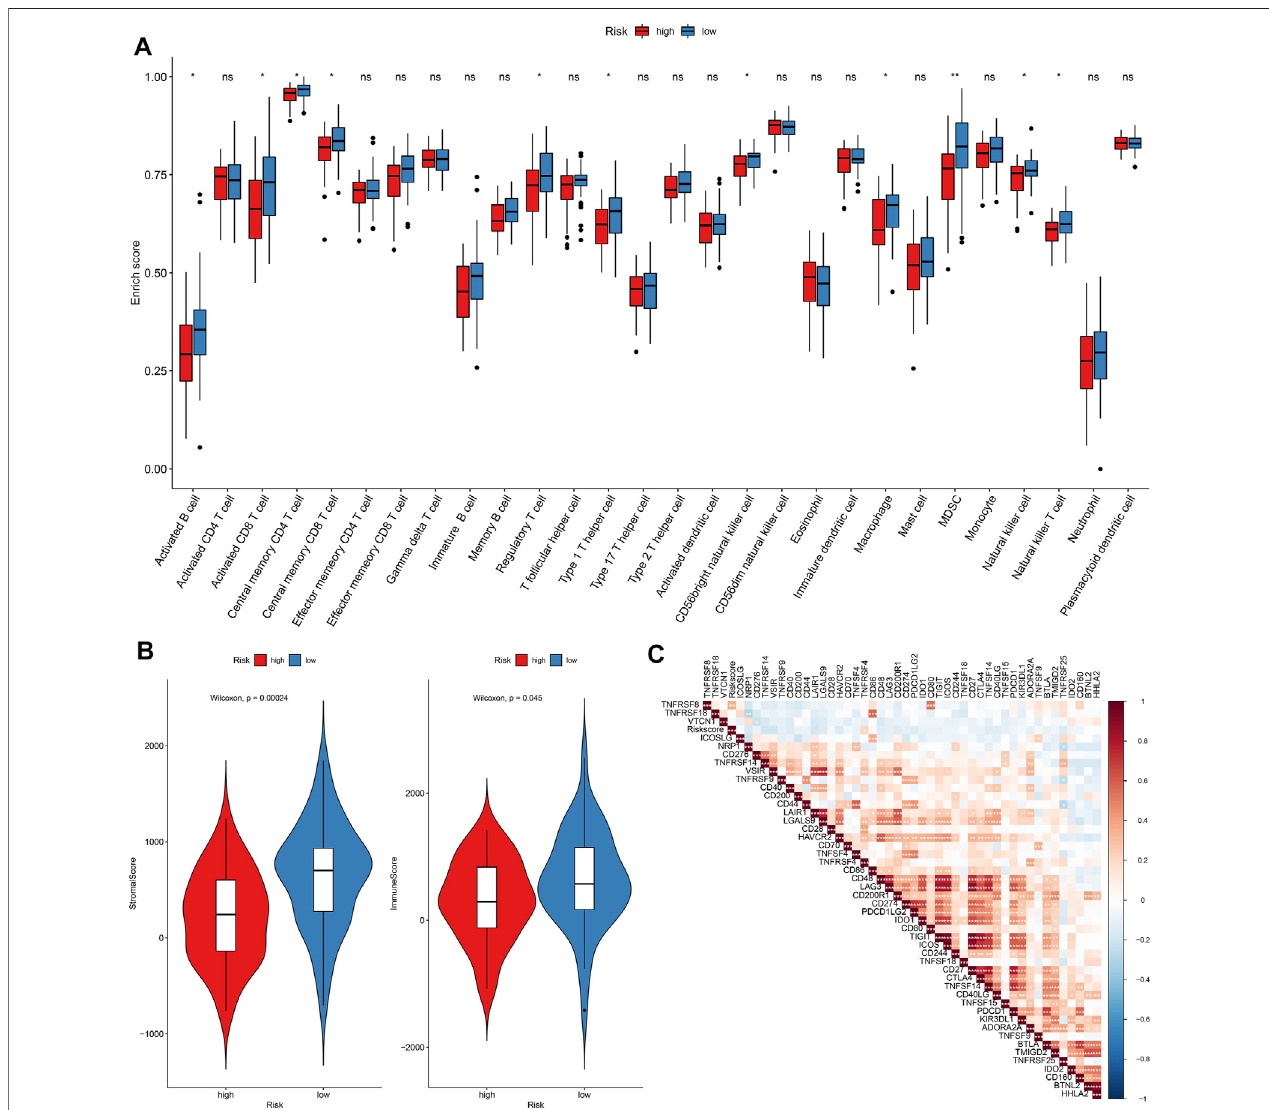
FIGURE 8 | Assessment of differences in immune status between high- and low-risk osteosarcoma in the TARGET cohort. (A) Relative enrichment scores of immune cell subpopulations in high- and low-risk osteosarcoma samples. (B) Distributions of stromal and immune scores between high- and low-risk osteosarcoma samples.ThedifferenceswereevaluatedthroughWilcoxontest. (C) Heatmap forthecorrelations between riskscoreand immune cellsubpopulationsinosteosarcoma. The darker the color, the stronger the correlation. Ns: not signi fi cant; * p < 005; ** p < 0.01; *** p <